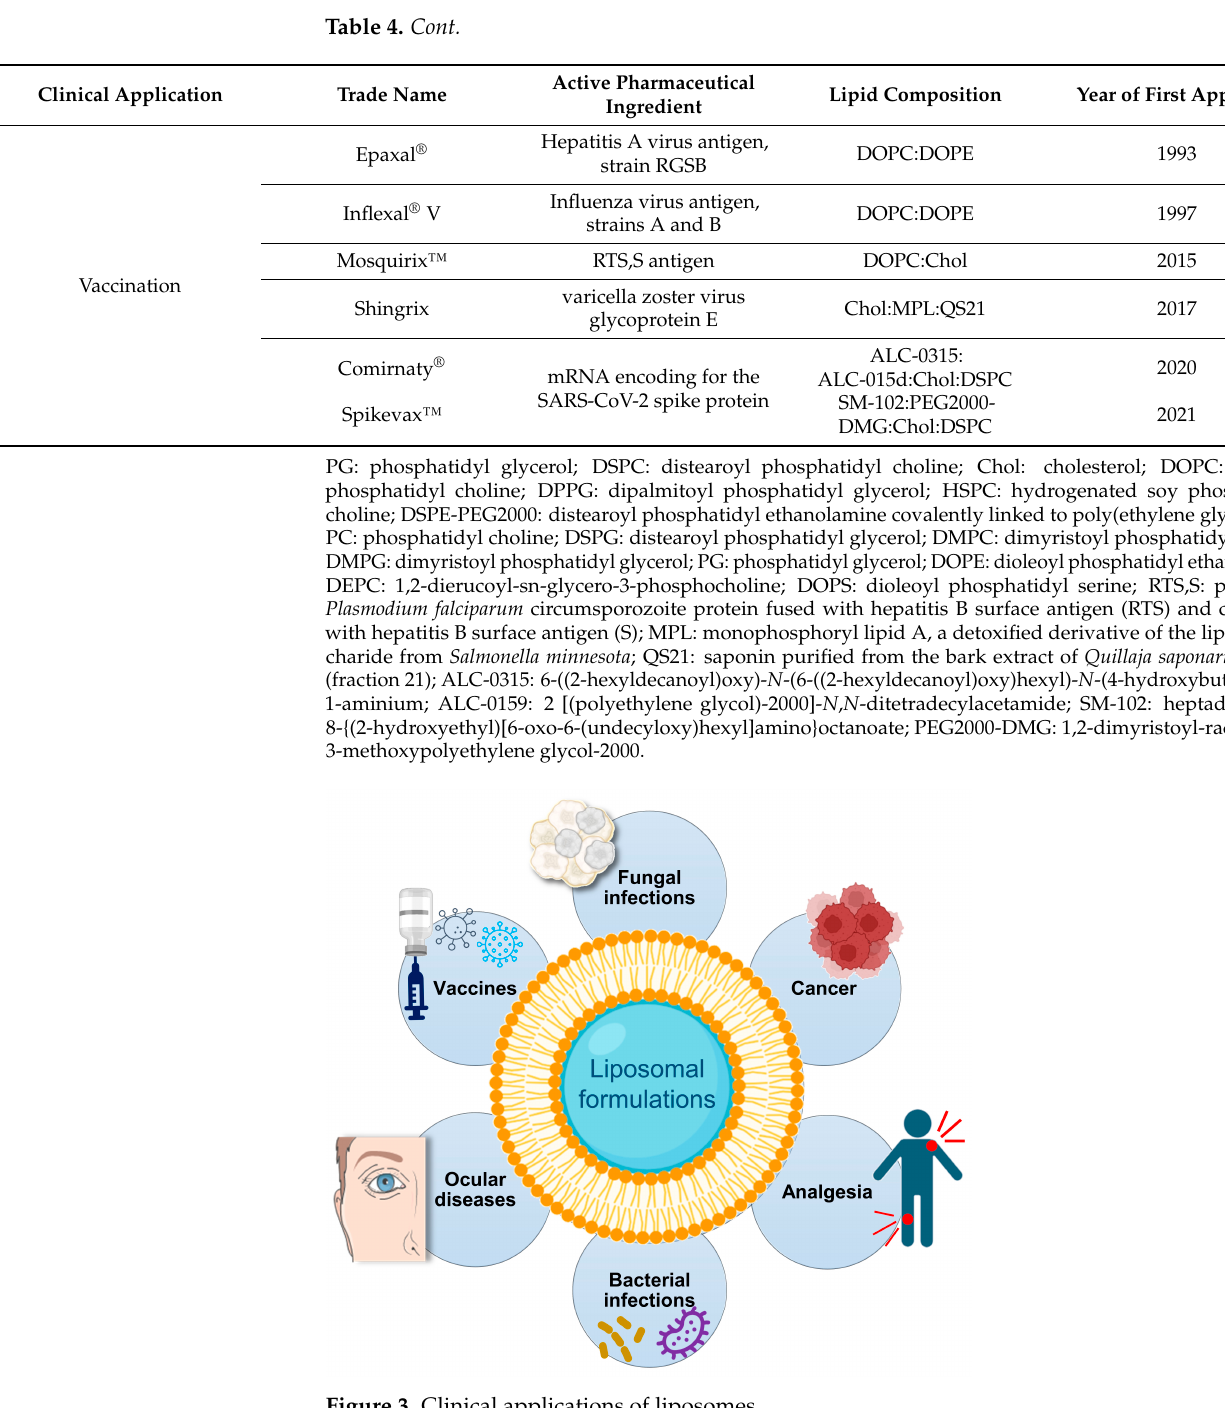
Figure 3. Clinical applications of liposomes.